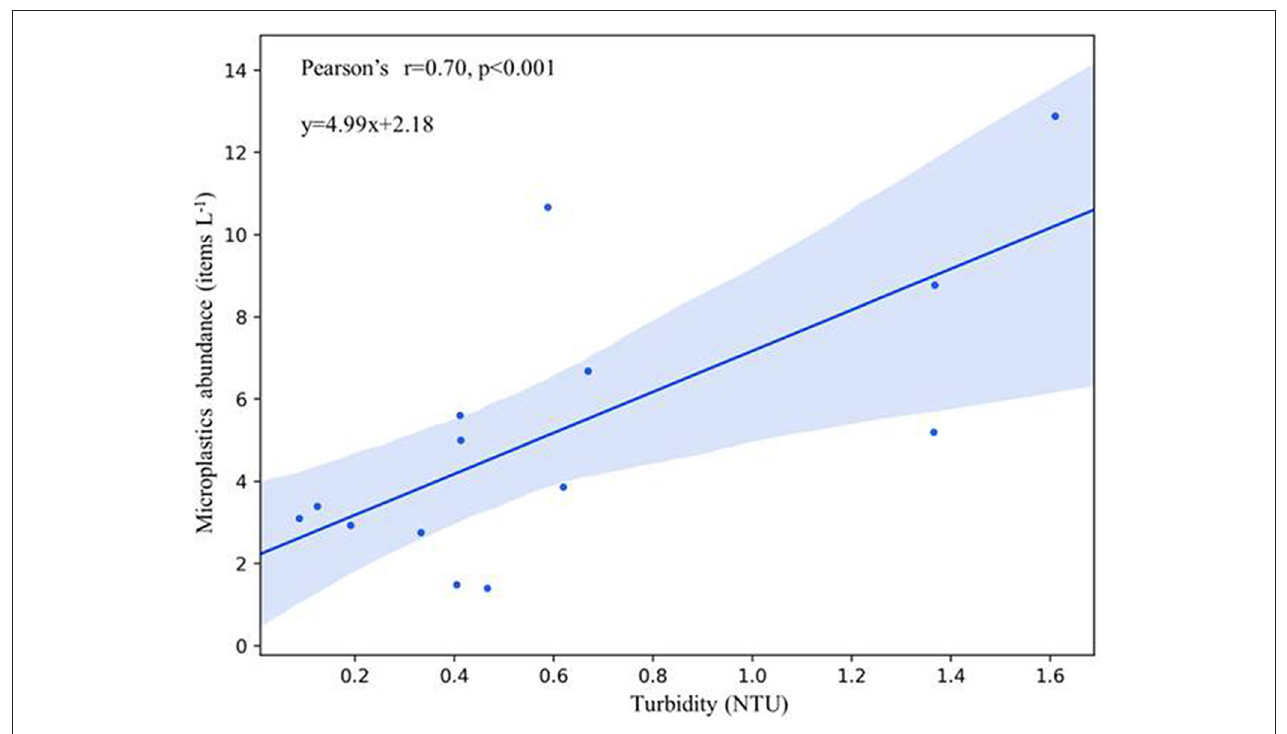
FIGURE 6 | Correlations between the microplastics abundance and turbidity at the near-bottom water layer. Linear least squares regression relationships were